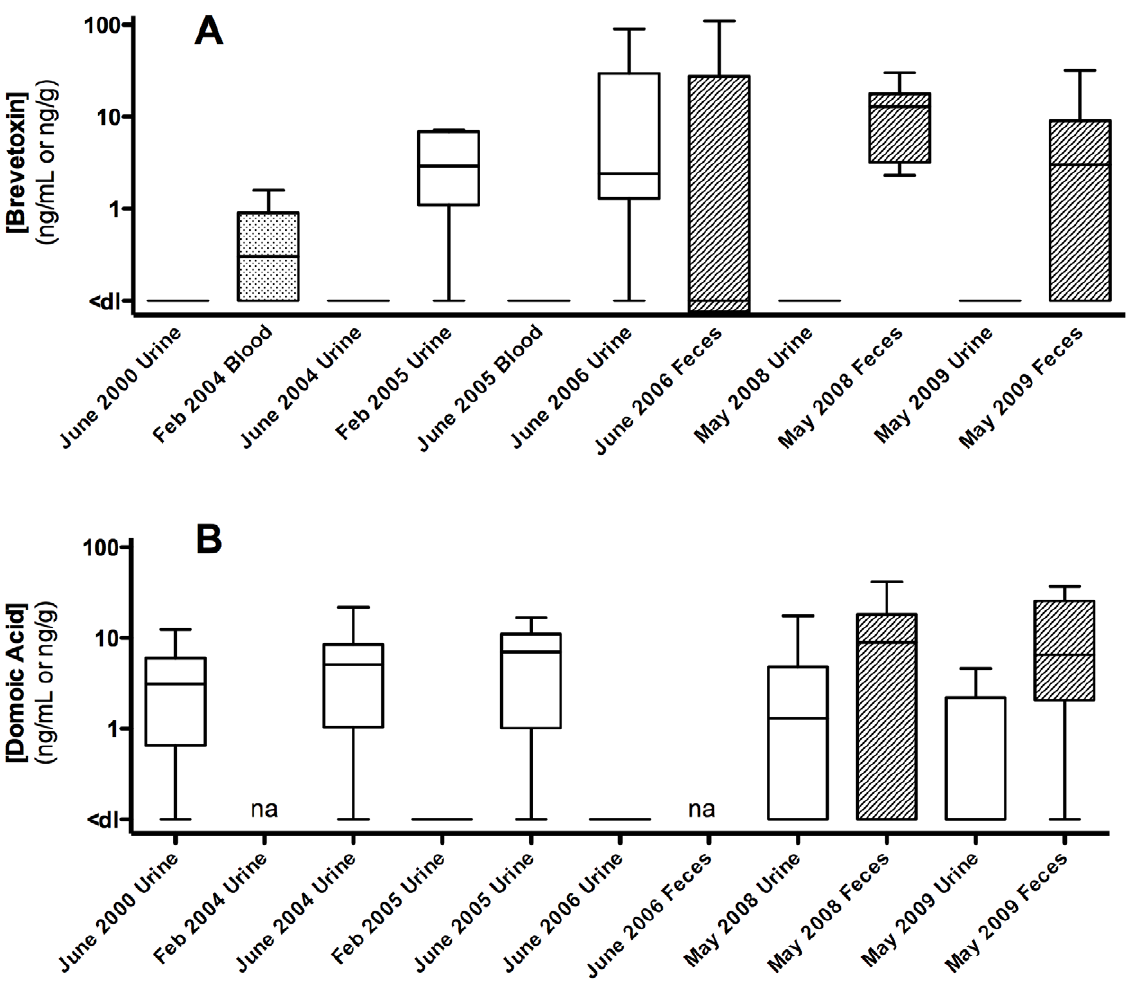
Figure 5. Biotoxin concentrations in urine, blood, and/or feces of Sarasota Bay, Florida dolphins between 2000–2009. (A) Brevetoxin was analyzed by RIA, ELISA, RBA, and/or LC/MS, and (B) domoic acid was analyzed by ELISA and/or LC/MS. Brevetoxin values are reported in ng PbTx- 3 equiv./g or/mL. Data are median, quartile, and minimum/maximum values indicated by the midline, box, and whisker lines; respectively. Raw data are available in Table S1 and Table S2. Note: ‘na’ denotes samples not available.